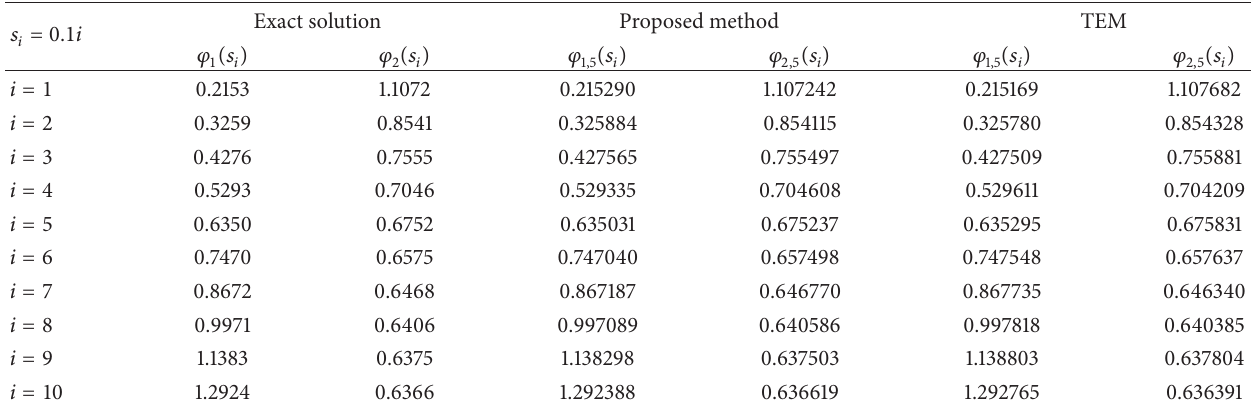
Table 1: Numerical results for Example